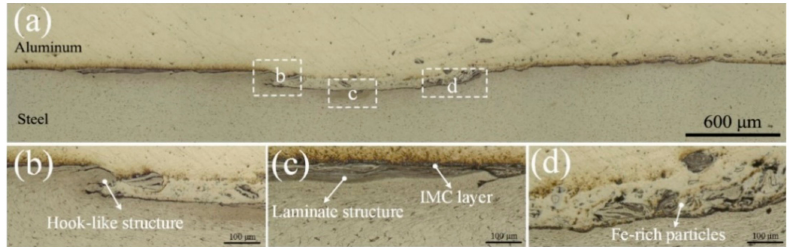
Figure 7. Interfacial macro-microstructures of Al/Fe lap joint with rotation speed of 1000 rpm and welding speed of 200 mm/min. ( a ) interfacial macrostructure; ( b ) hook-like feature; ( c ) laminate structure; and ( d ) particles composite-like structure.